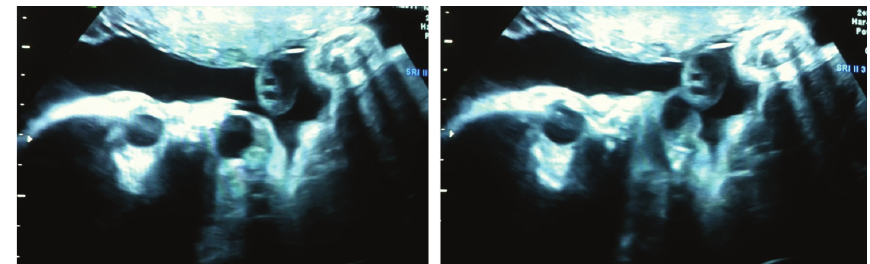
Figure 2: Ultrasound image showing how the tumor moves with the tongue movements and it is completely out of the fetal mouth.